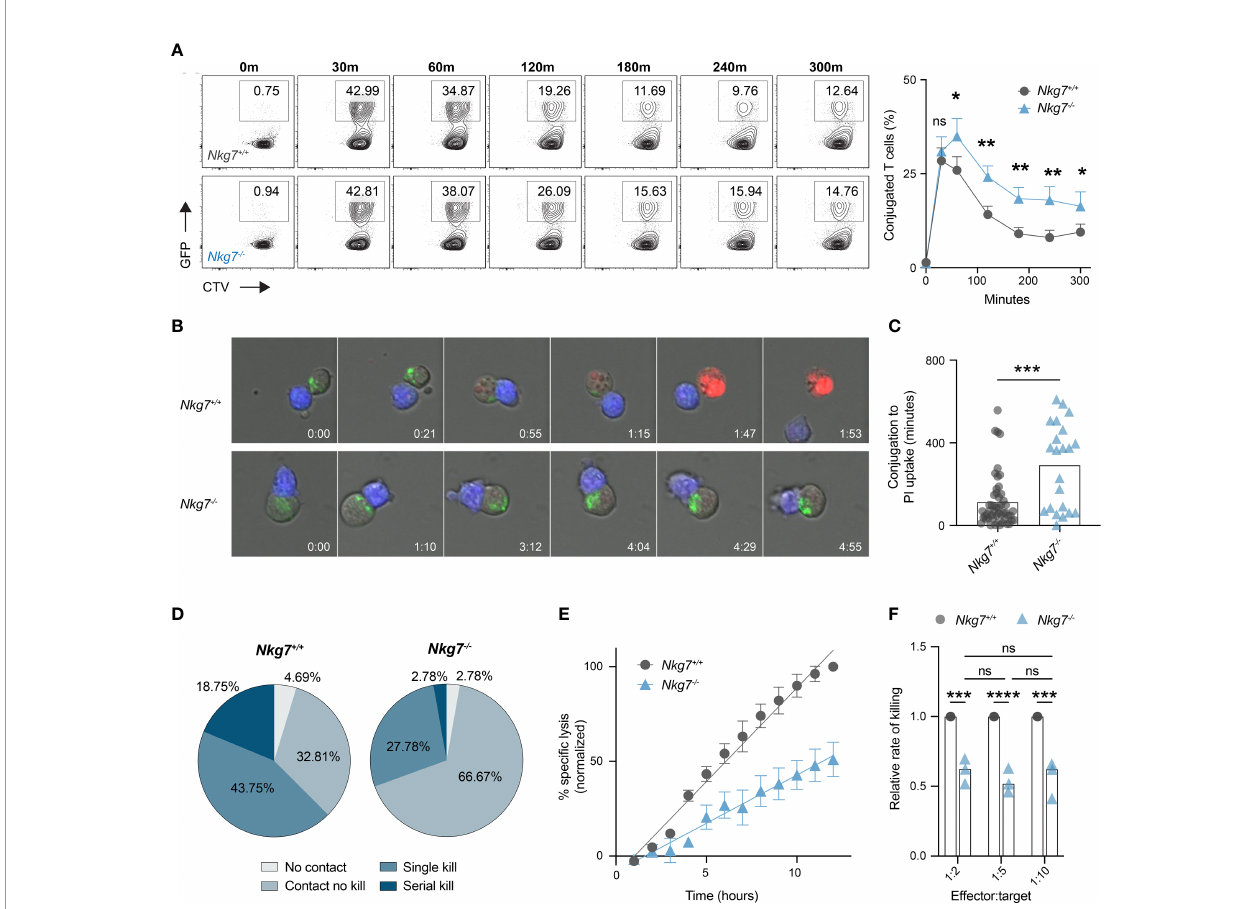
FIGURE 4 | NKG7 shortens immune synapse duration and promotes ef fi cient serial killing. (A) Frequency of CD8+ T cells conjugated to P815 target cells at indicated timepoints evaluated by fl ow cytometry. 72 hour activated Nkg7 +/+ or Nkg7 -/- CD8+ T cells were labelled with cell trace violet (CTV) and co-cultured with anti-CD3/28- coated GFP-labelled P815 cells. Time indicates minutes of co-culture. Plots are gated on CTV + cells and frequency of conjugates was calculated as CTV + GFP + as a percent of all CTV + cells. Data is quanti fi ed in right panel, Wilcoxin matched-pairs signed rank test, n = 3. (B) Live cell imaging time-lapse montage of CTV-labelled 72 hour activated Nkg7 +/+ or Nkg7 -/- CD8+ T cells (blue) co-cultured with anti-CD3/28 antibody-coated P815 target cells. Lysotracker (green) was added to co-cultures for cell clarity and PI was added to measure target cell death. Time indicates hours of co-culture. (C) From (B) , time taken between T cell/target conjugation and target cell death as measured by PI uptake, unpaired t test with Welch ’ s correction, n = 21-55 T cells evaluated, pooled from 2 independent experiments over a 14-hour co-culture. (D) Frequency of T cells from (B) making no contact with any target (No contact), making contact without killing (Contact no kill), killing a single target only (Single kill) or killing more than one target (Serial kill) during the fi rst 7 hours of co-culture. (E) Speci fi c lysis of 51 Cr-labelled anti-CD3/28-coated P815 tumor cells (targets) co-cultured with 72 hour activated Nkg7 +/+ or Nkg7 -/- CD8+ T cells (effectors) at an effector to target ratio of 1:5 for indicated lengths of time, measured by 51 Cr release. Data was normalized by converting the maximum killing by Nkg7 +/+ CD8+ T cells to 100%. (F) Relative rate of killing measured from assays set up as in (E) at indicated effector to target ratios, with relative rate measured as the slope of the Nkg7 -/- killing curve relative to the Nkg7 +/+ killing curve at the corresponding effector to target ratio, 2-way ANOVA Sidak ’ s multiple comparisons test, n = 3. All error bars show +/- SEM. ns – not signi fi cant, * P < 0.05, ** P < 0.01, *** P < 0.001, **** P <